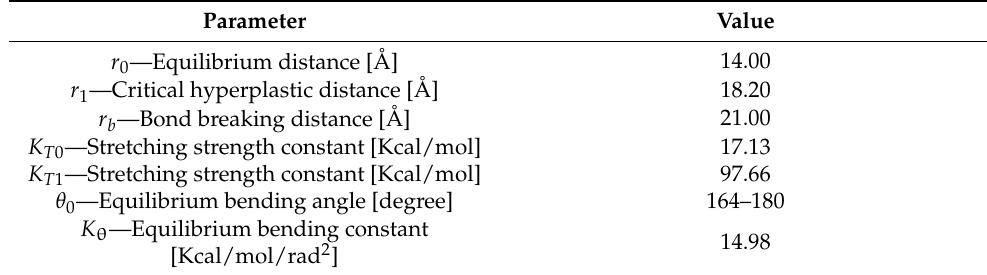
Table 2. Energy parameters of tropocollagen molecule.